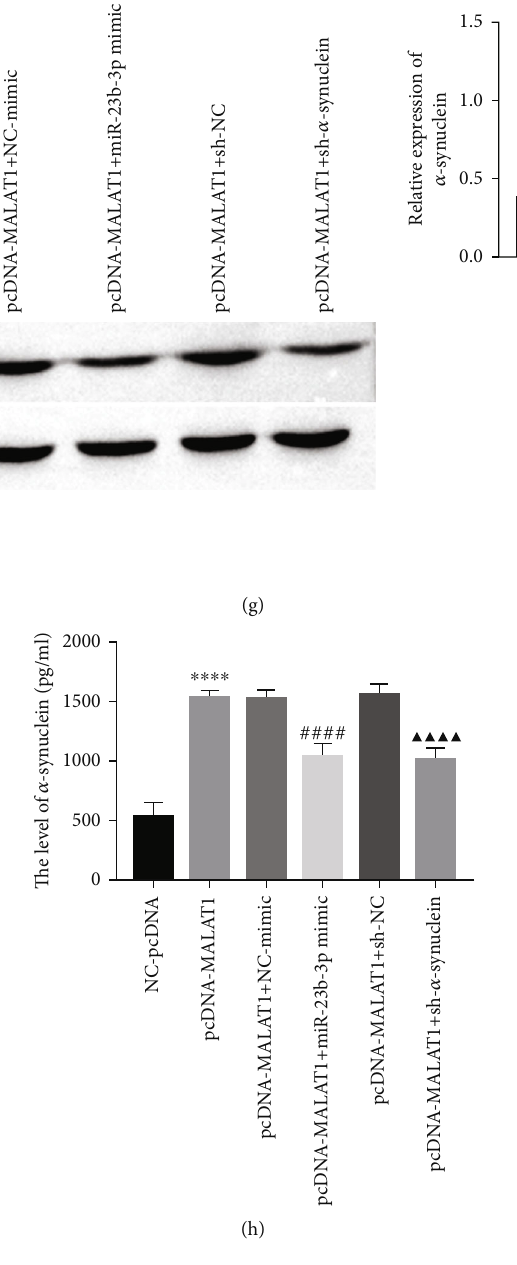
Figure 2: MALAT1 acts as a miR-23b-3p sponge to regulate α -synuclein expression (MN9D cells). (a) StarBase predicts the targeting binding site between MALAT1 and miR-23b-3p. (b) Dual luciferase reporter assay was used to verify the targeting binding relationship (MALAT1 and miR-23b-3p), ∗∗ P < 0 : 01 vs. NC-mimic. (c) The expression of miR-23b-3p was detected by RT-qPCR, ∗∗∗∗ P < 0 : 0001 vs. si-NC and # P < 0 : 05 vs. pcDNA. (d) StarBase predicts the targeting binding site between miR-23b-3p and α -synuclein. (e) Dual luciferase reporter assay was used to verify the targeting binding relationship (miR-23b-3p and α -synuclein), ∗ P < 0 : 05 vs. NC-mimic. (f) The expression of α -synuclein was detected by western blot, ∗∗ P < 0 : 01 vs. NC-mimic and # P < 0 : 05 vs. NC-inhibitor. (g) The expression of α -synuclein was detected by western blot, ∗ P < 0 : 05 vs. NC-pcDNA, # P < 0 : 05 vs. pcDNA-MALAT1+NC-mimic, and ▲ P < 0 : 05 vs. pcDNA-MALAT1+sh-NC. (h) The level of α -synuclein was detected by ELISA, ∗∗∗∗ P < 0 : 0001 vs. NC-pcDNA, #### P < 0 : 0001 vs. pcDNA-MALAT1+NC-mimic, and ▲▲▲▲ P < 0 : 0001 vs.